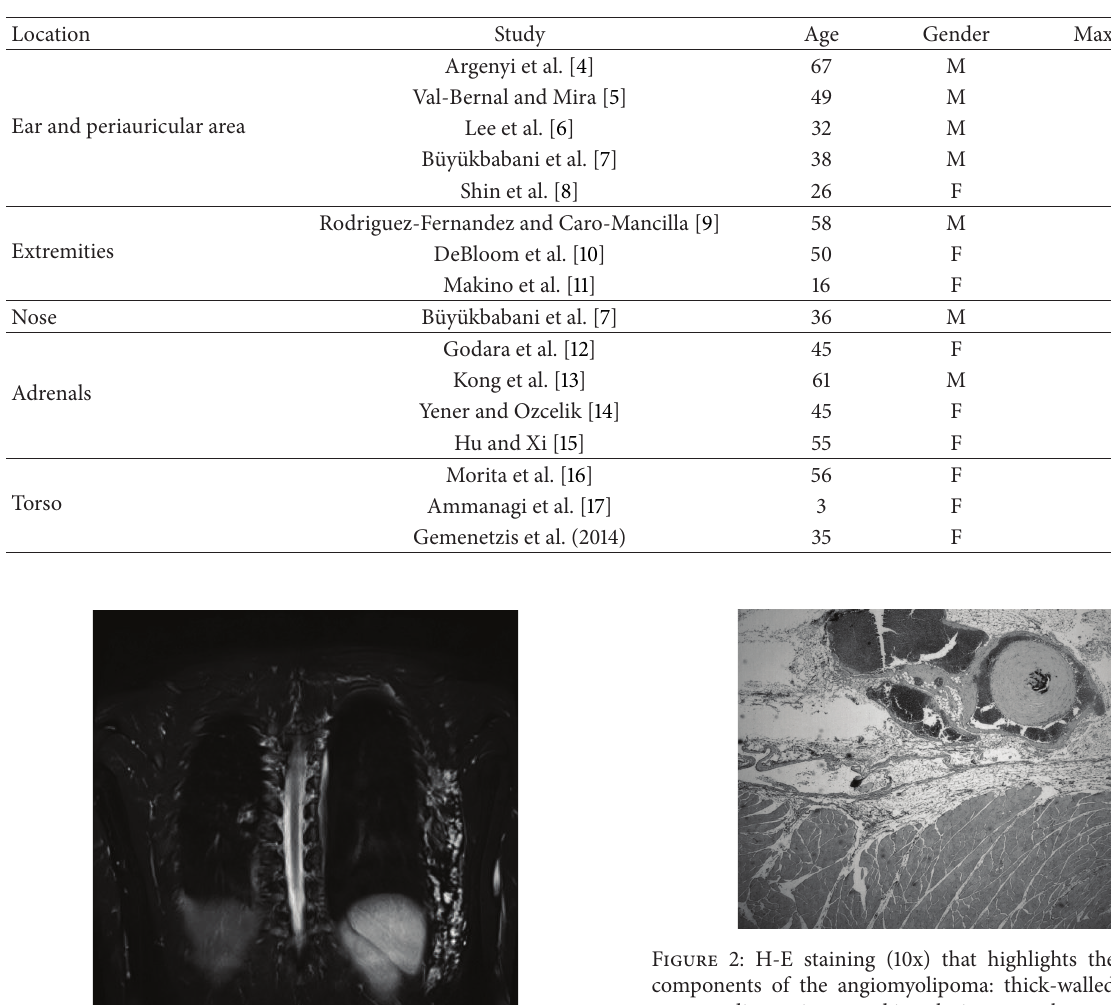
Table 1: Locations of extrarenal manifestations of angiomyolipomas reported in the literature.